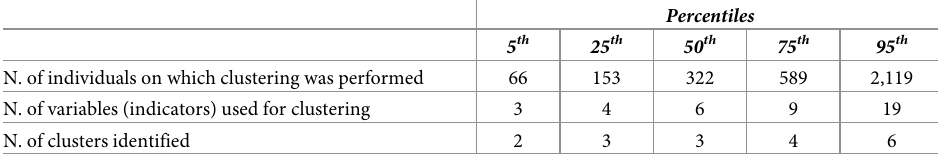
Table 1. Percentiles of interest for the number of individuals on which clustering was performed, the number of indicators, and the number of clusters identified, across the 191 studies reviewed.